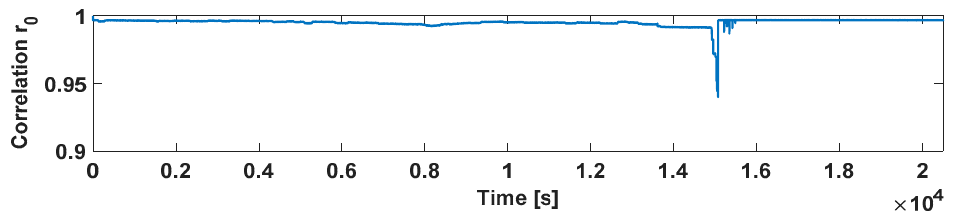
Figure 7. Evolution of r 0 for a flow rate of 1 L/h with the reset strategy enabled.